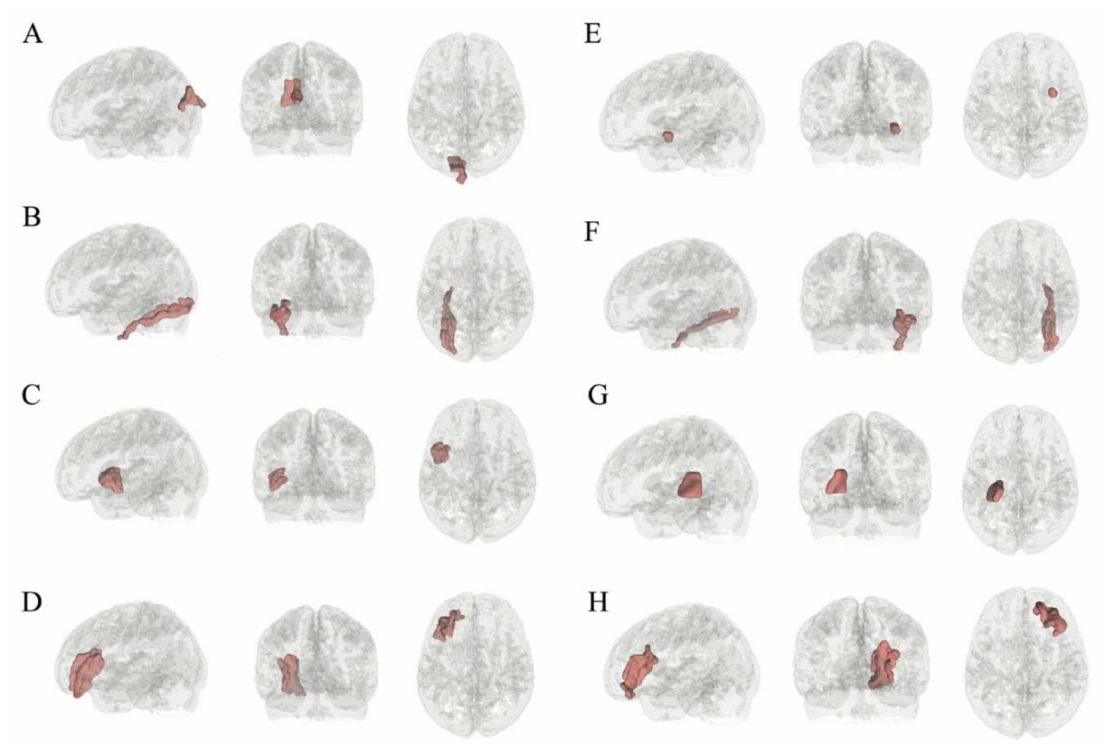
Figure 2. Identified features that discriminated IGD subjects and HCs. IGD = internet gaming disorder; HC = healthy control; ( A ) left cuneus; ( B ) left fusiform; ( C ) left parsopercularis; ( D ) right rostral middle frontal; ( E ) right uncinate fasciculus; ( F ) right fusiform; ( G ) left internal capsule; ( H ) left rostral middle frontal.